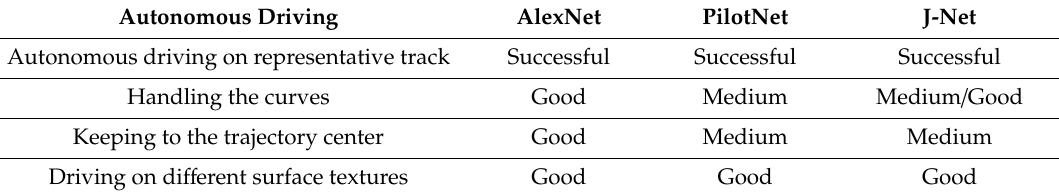
Table 4. Qualitative performance evaluation of autonomous driving using AlexNet, PilotNet, and J-Net. Autonomous Driving